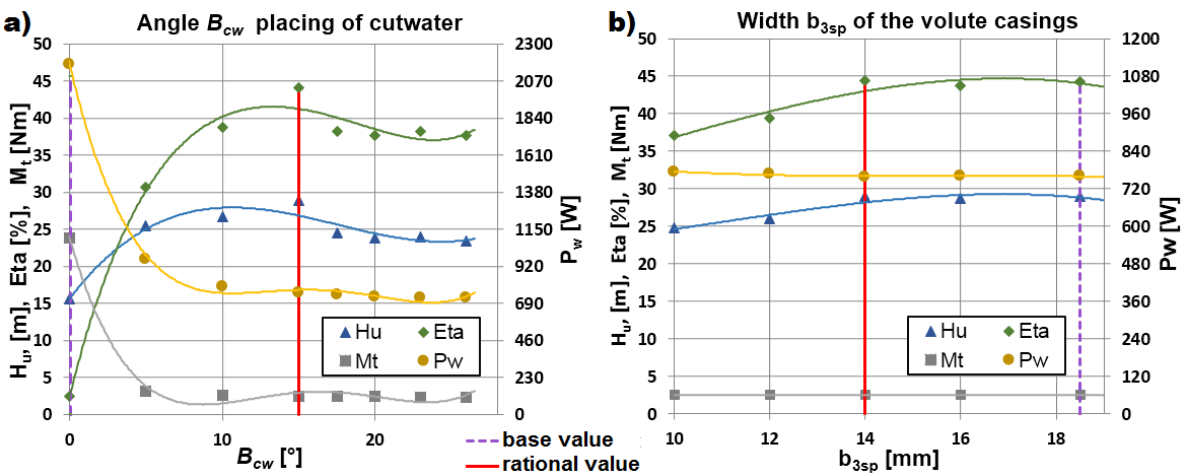
Figure 9: Influence of changes of the angle B cw location of a volute tongue (a) and the width b 3 sp (b) of the volute